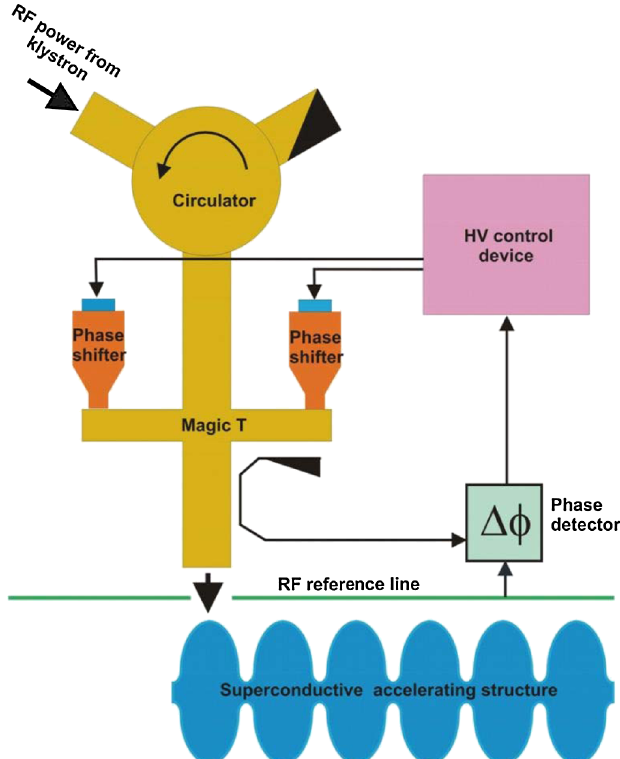
FIG. 1. External tuner in a magic- T configuration with adjust- able phase shifters. Each phase shifter works in one-port con- figuration, with its second port being